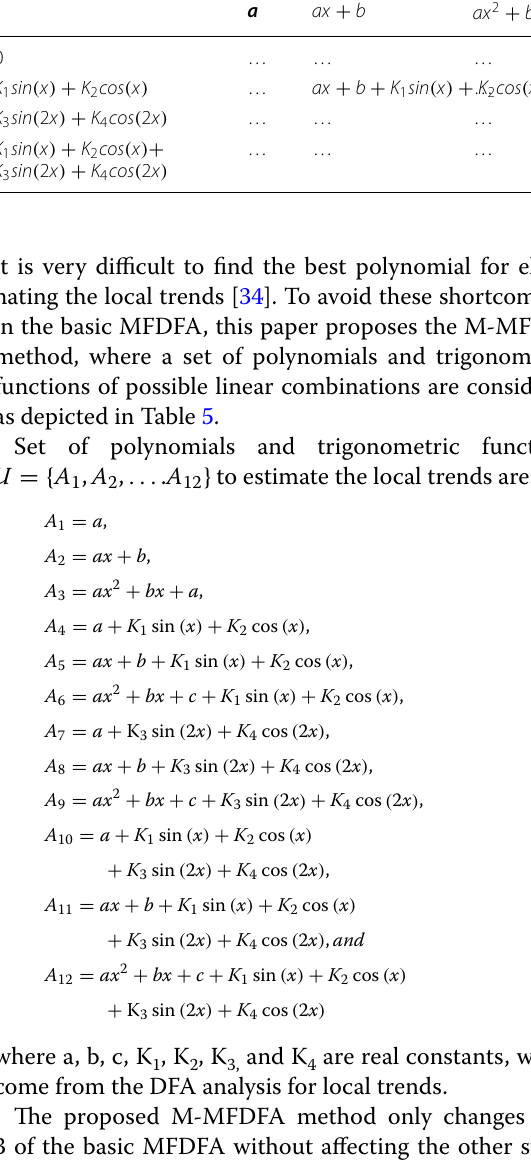
Table 5 Local trends estimation for each segment ( v ) with the functions set U Trigonometric functions Polynomial